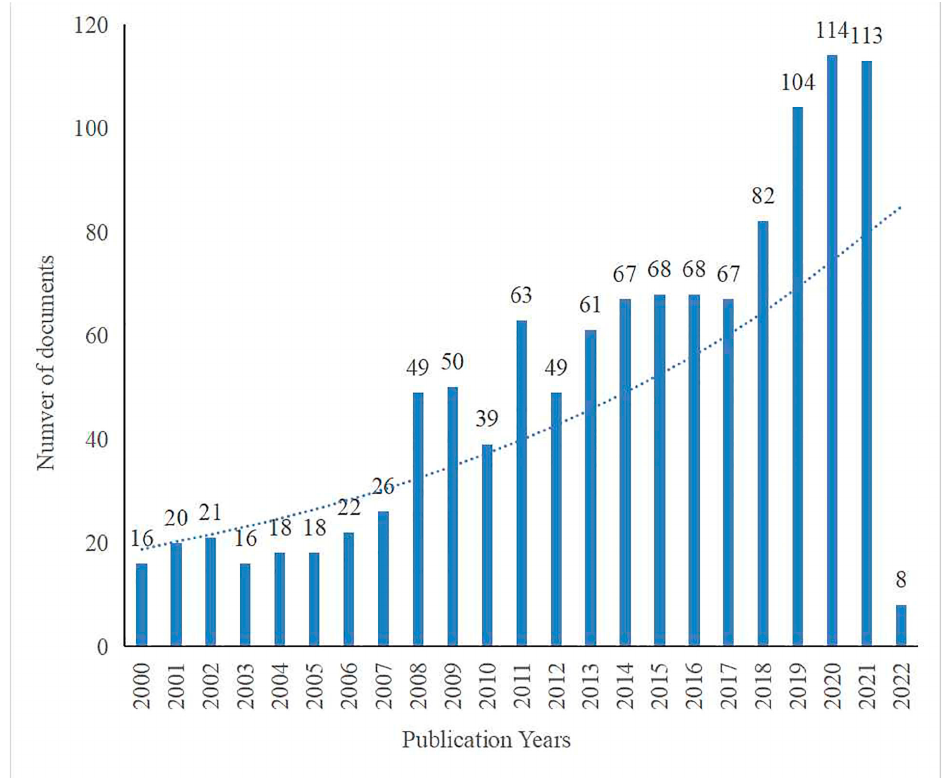
Figure 2. Distribution of publications by year on therapy for POI from 2000 to 2022. The bibliographic data were downloaded on 14 February 2022.